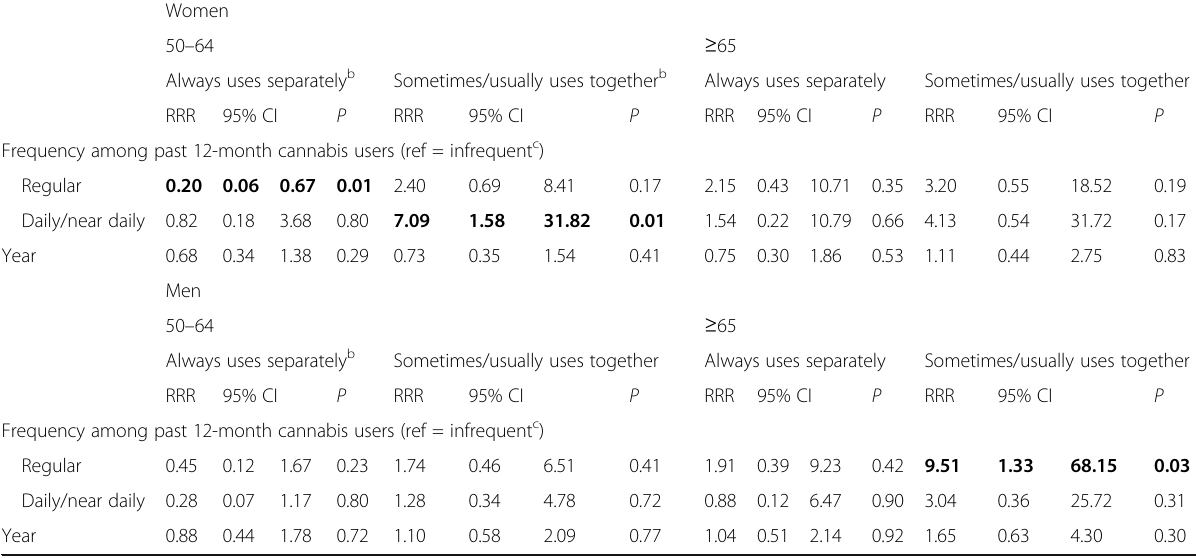
Table 4 Results from multinomial regression models a of past 12-month cannabis use frequency regressed on co-use of cannabis and alcohol, 2014 – 2016 Washington state general population ( N = 5429)